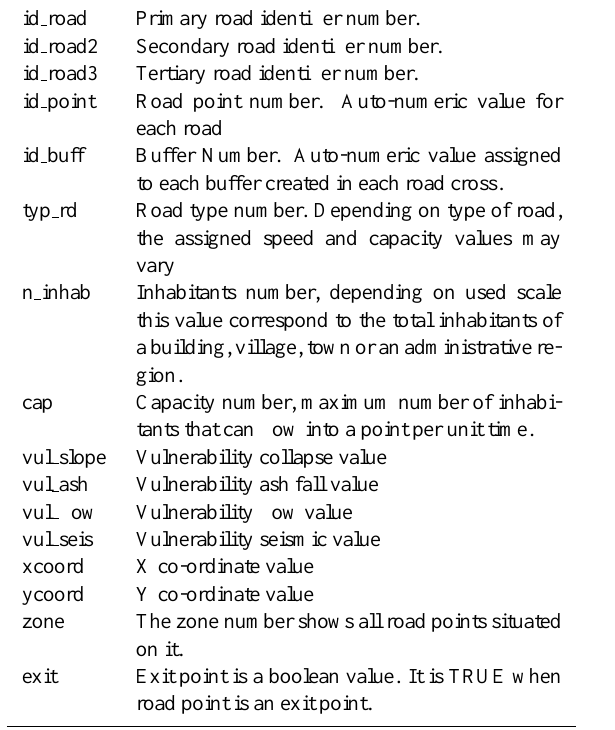
Table 1. Attribute table of road network point layer.